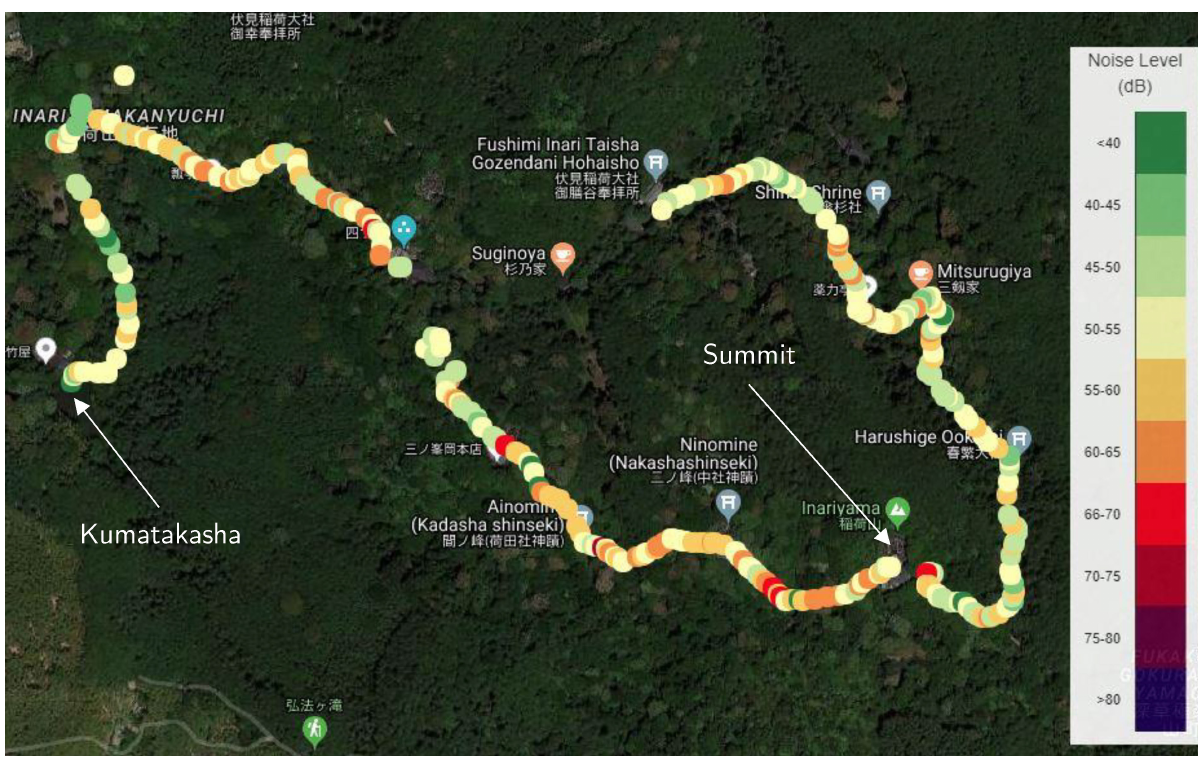
Figure 11: Soundscape of round trip from Kumatakasha to the summit